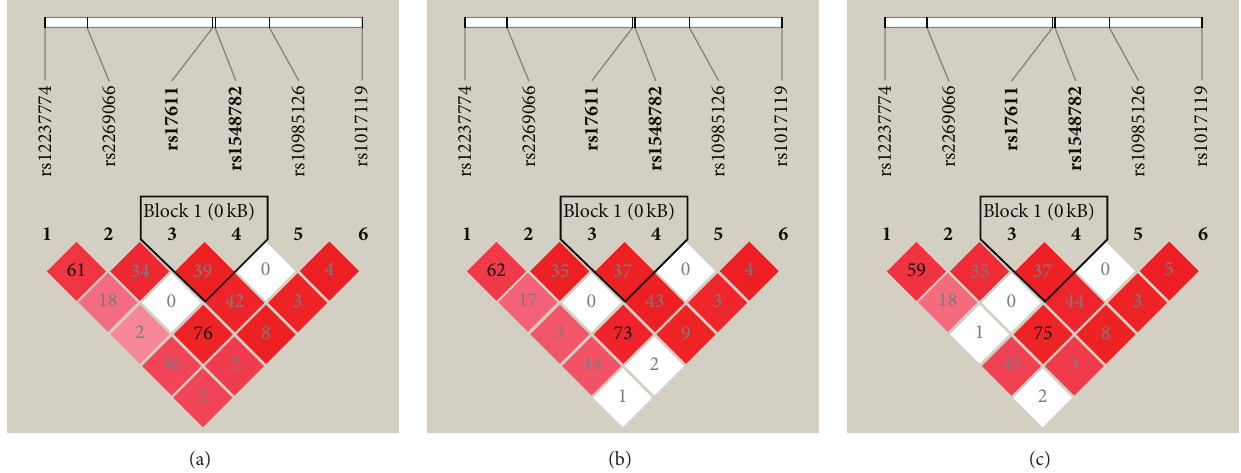
Figure 1: Linkage disequilibrium (LD) structure of the C5 locus for DR (a), NPDR (b), and PDR (c). LD was measured using data from all controls and total DR and its subtypes. The haplotype block was defined by the confidence interval method implemented in the Haploview software. The LD ( 𝑟 2 ) between any two SNPs is listed in the cross cells. DR: diabetic retinopathy; NPDR: nonproliferative diabetic retinopathy; PDR: proliferative diabetic